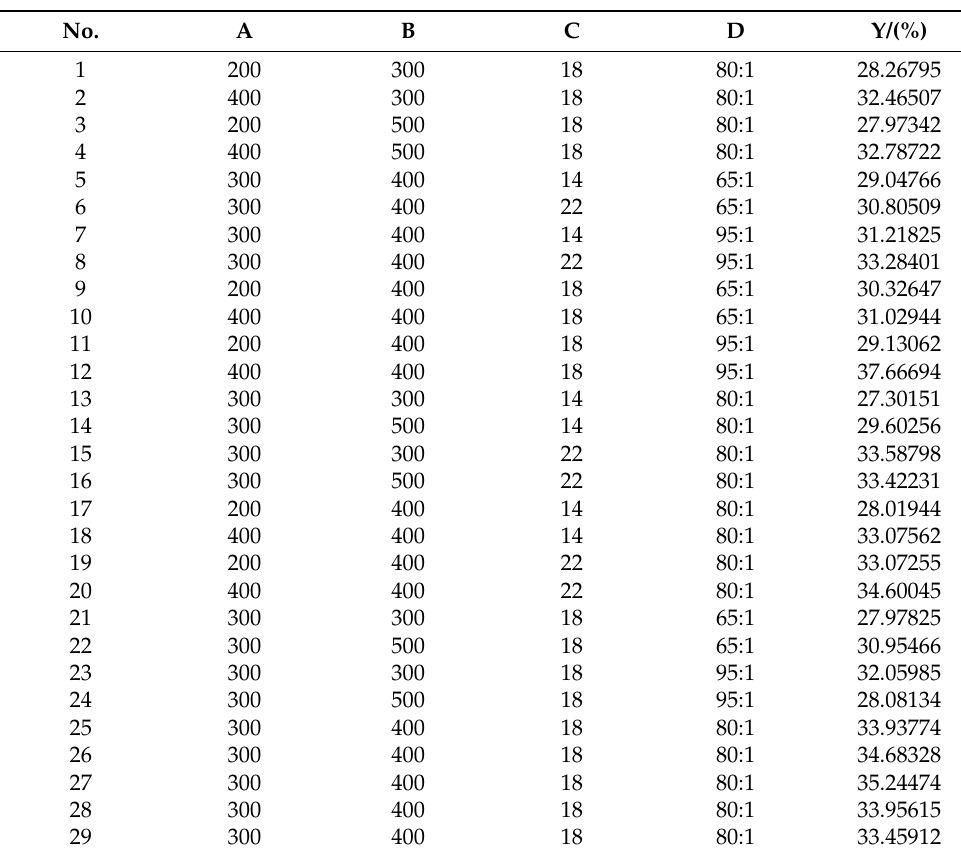
Table 2. RSM design and results. (A is the microwave power/(W), B is the ultrasonic power/(W), C is the extraction time/(min), and D is the liquid-to-material ratio/(g/mL). In addition, − 1 is level 1; 0 is level 2; 1 is level 3.).